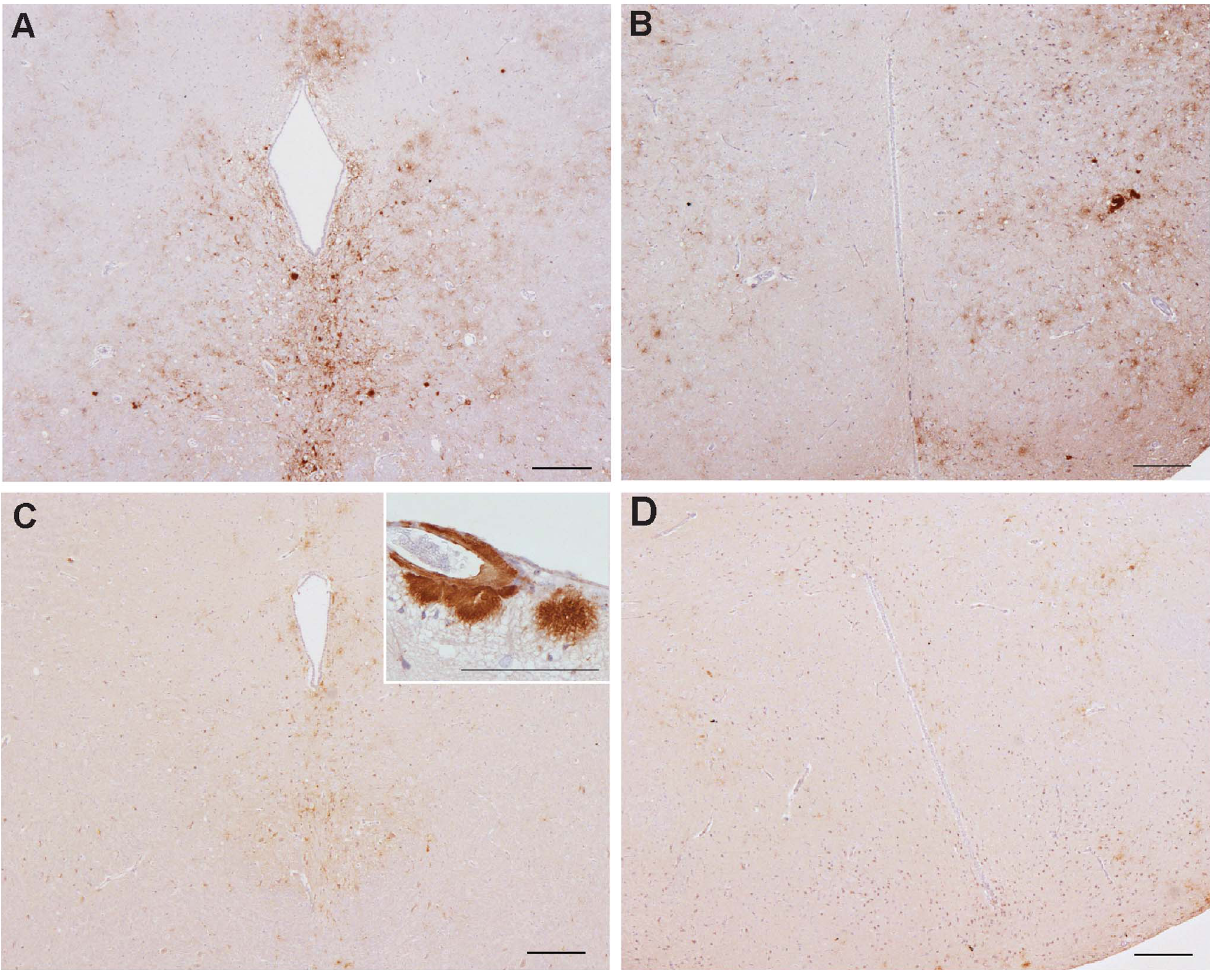
Figure 5. PrP Sc distribution patterns in inoculum-18 and PMCA-18 mice. The distribution of PrP Sc in the midbrain raphe and hypothalamus of inoculum-18 mice are shown in (a) and (b), respectively, and in PMCA-18 mice in (c) and (d), respectively. Perivascular, lepto-meningial plaques observed in PMCA-18 mice are shown in (c inset). Scale bars represent 200 m m or 100 m m (c inset).